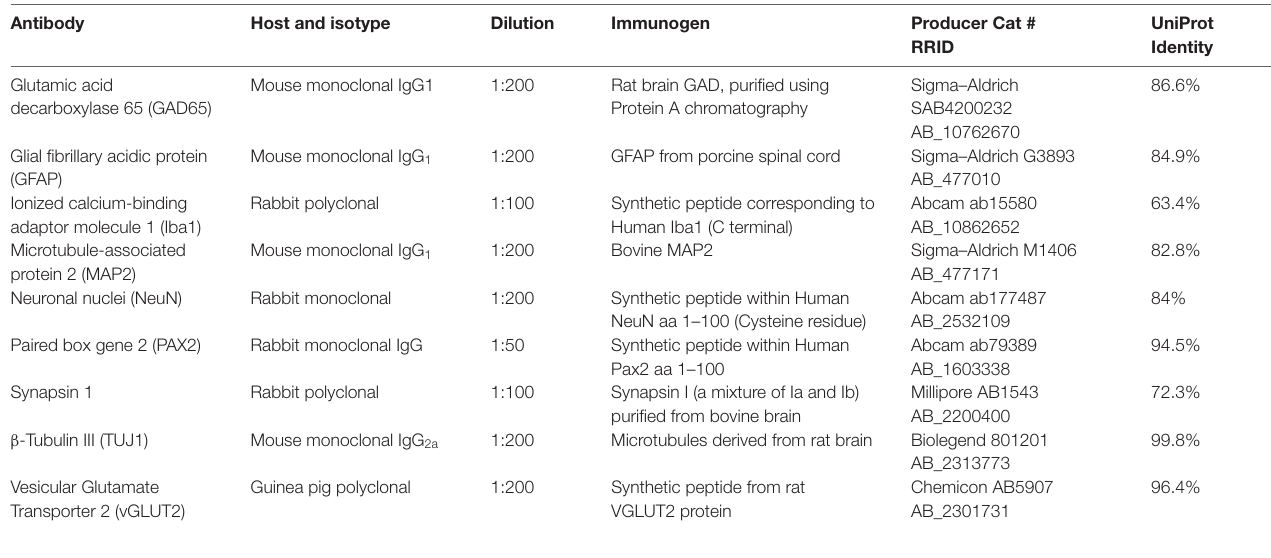
TABLE 2 | Primary antibodies used in this